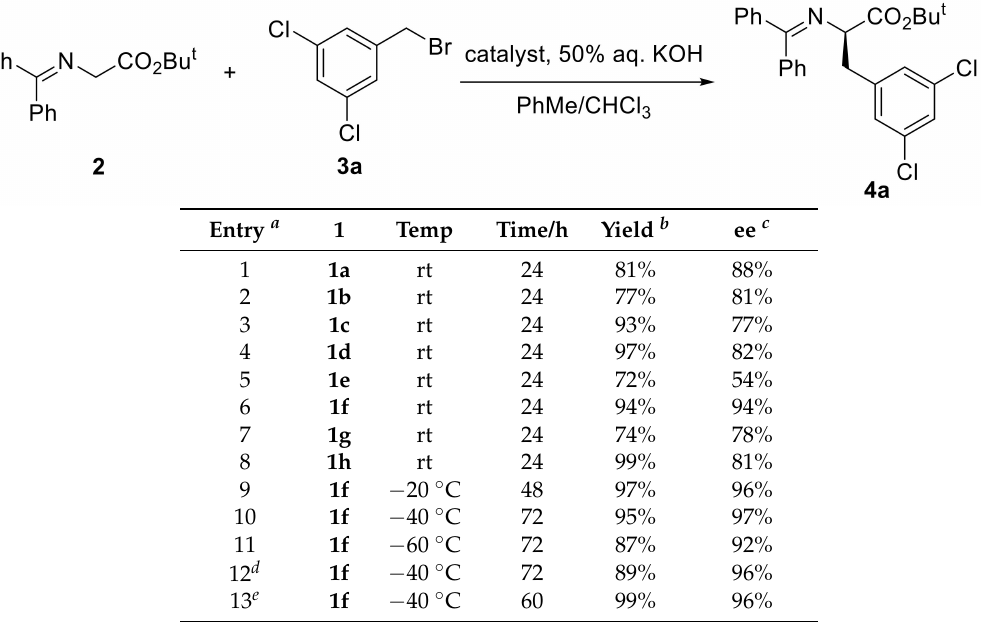
Table 1. Optimization of the reaction